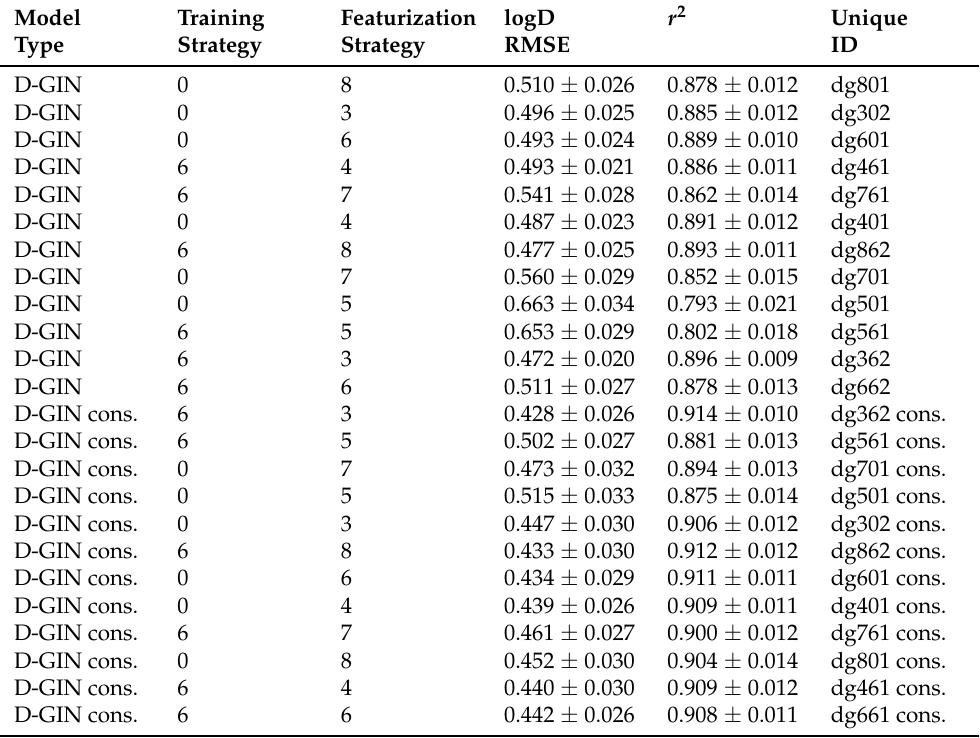
Table A16. Shows the logP RMSE and r 2 results for the D-GIN model type used during this survey. The last column consists of the unique identifier. Training strategy 0 represents a training strategy combining logD, logS, and logP, 1 represents a strategy combining logD and logP, 2 stands for a combination of logD and logS, 3 represents a strategy using logS and logP, 4 represents a strategy using logD, 5 represents a strategy using logS, and 6 represents a strategy using